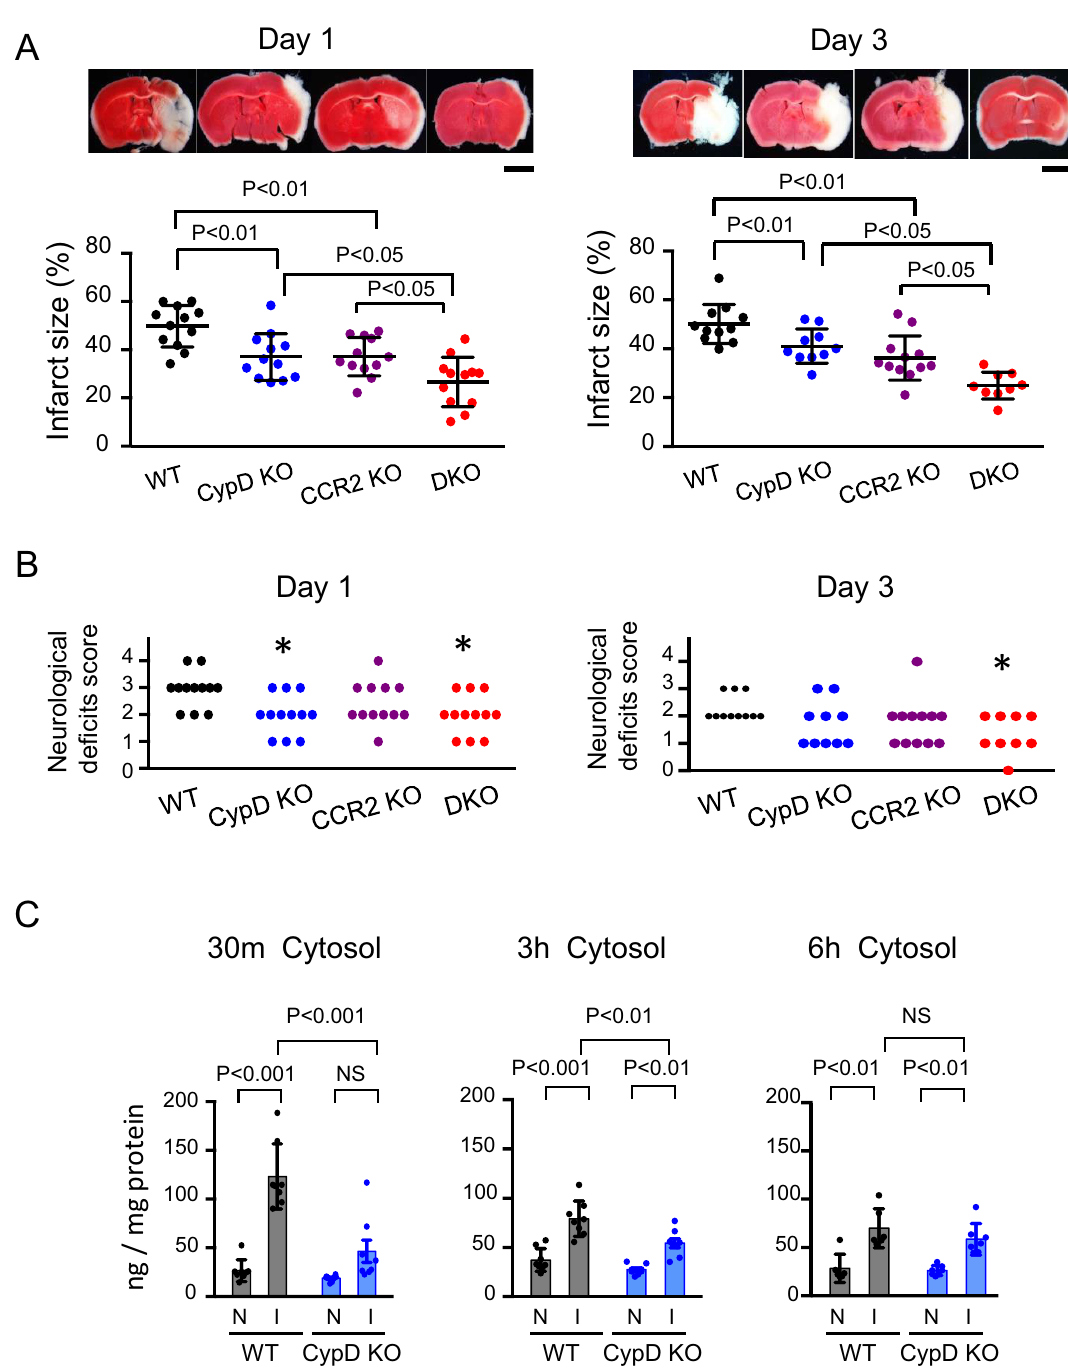
Figure 1. Double knockout of CypD and CCR2 decreased cerebral IR injury compared to CypD- or CCR2- single knockout in mice. ( A ) Cross-sectional pictures of brains harvested 1 day and 3 days after IR injury. Graphs demonstrate quantitative results of TTC-negative infarct area. The data are represented as the mean ± SD (N = 9–12 mice per group), and they were analyzed by one-way ANOVA followed by Bonferroni’s multiple comparison tests. Scale bar: 2 mm. ( B ) Neurological deficits score evaluated 1 day and 3 days after IR injury. Data were analyzed by the nonparametric Kruskal–Wallis test. * P < 0.05 versus WT mice. ( C ) Quantitative data of cytochrome c in the cytosol fraction isolated from brain tissues after IR injury. I: ischemic hemisphere, N: nonischemic hemisphere. The data represent the mean ± SD and compared using two-way ANOVA followed by Bonferroni’s multiple comparison